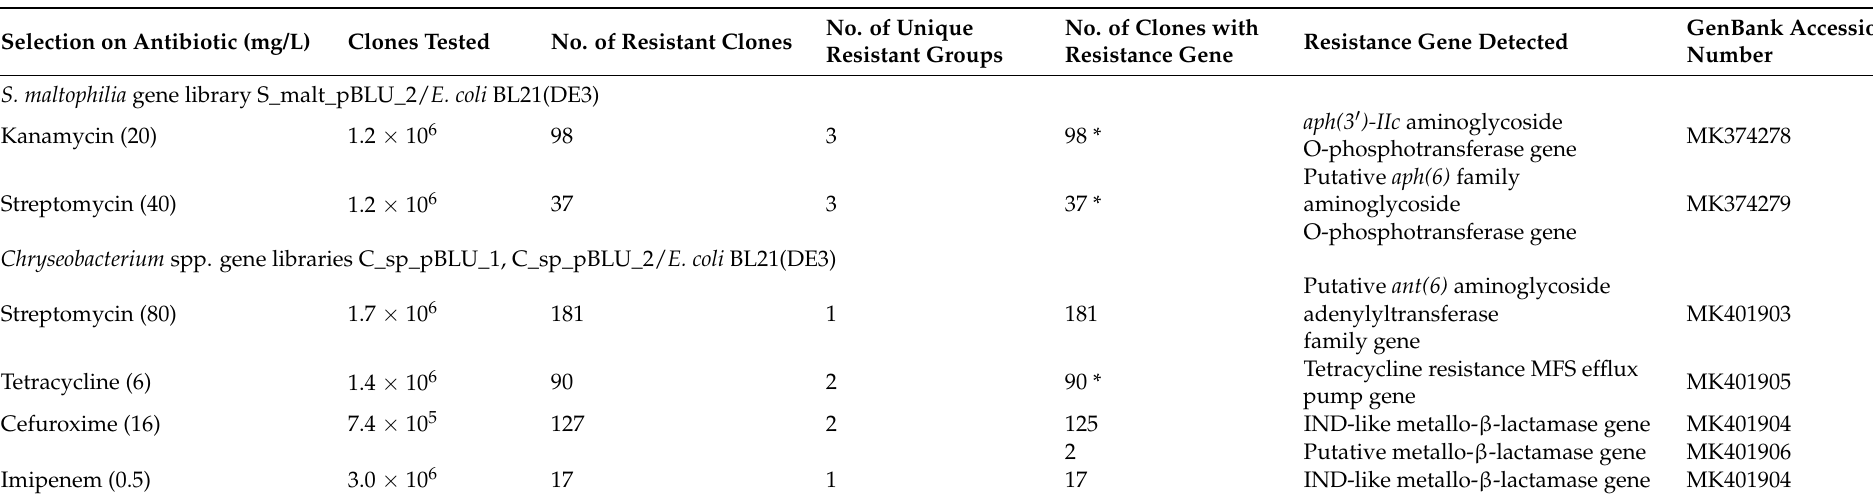
Table 2. S. maltophilia and Chryseobacterium spp. ARGs identified by functional gene library